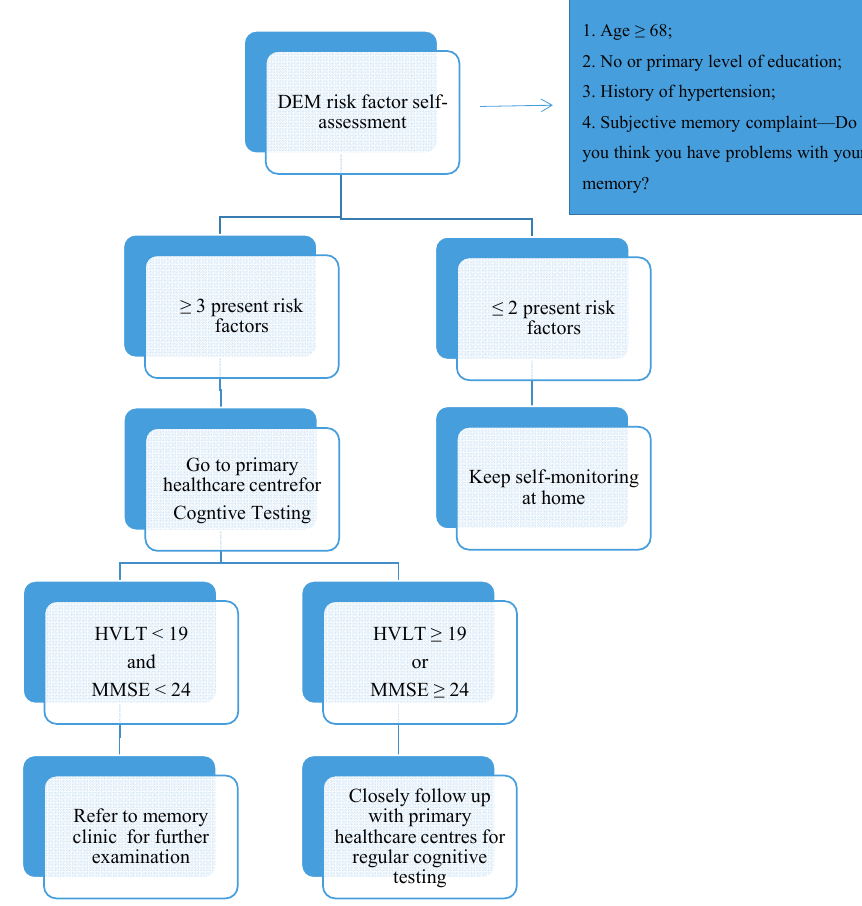
Figure 3. Proposed DEM self-checklist and case management